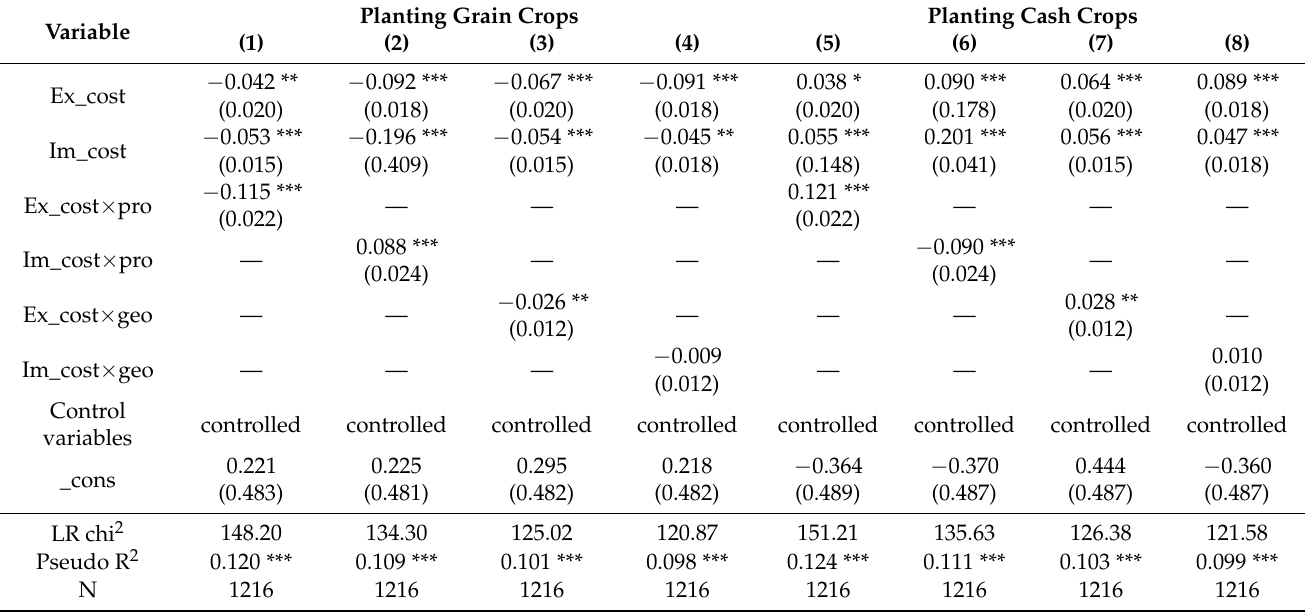
Table 5. Analysis of